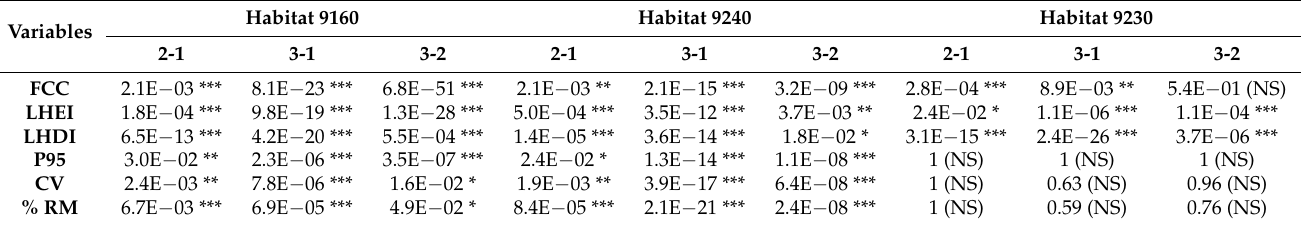
Table 4. Dunn’s test results for habitats 9160, 9240, and 9230. *: p -value < 0.05; **: p -value < 0.01; ***: p -value < 0.001; NS: non-significant. Additionally, 9160 is Quercus robur habitat, 9230 is Quercus pyrenaica habitat, and 9240 is Quercus faginea